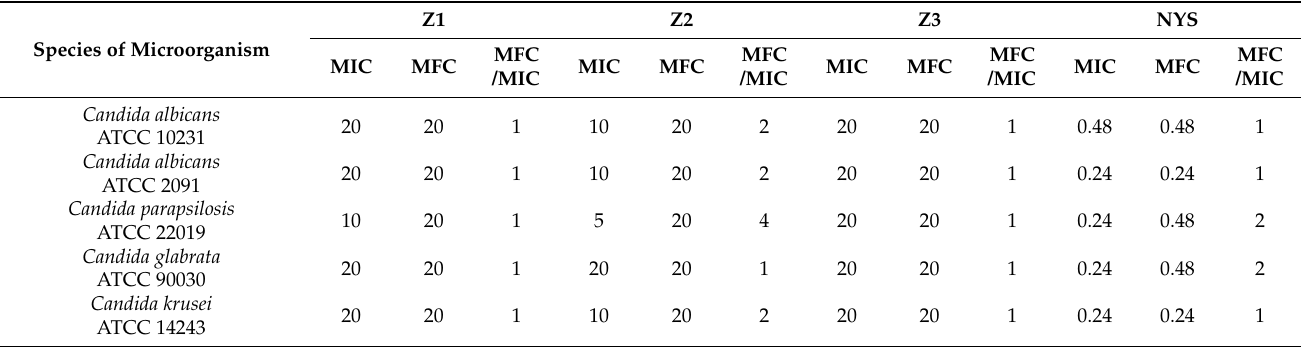
Table 3. The activity data of Z. bungeana extracts expressed as MIC (Minimum Inhibitory Concen- tration), MFC (Minimum Fungicidal Concentration) [mg/mL] and MFC/MIC value against the reference strains of fungi (NYS —nystatin (MIC and MFC) [ µ g/mL]).